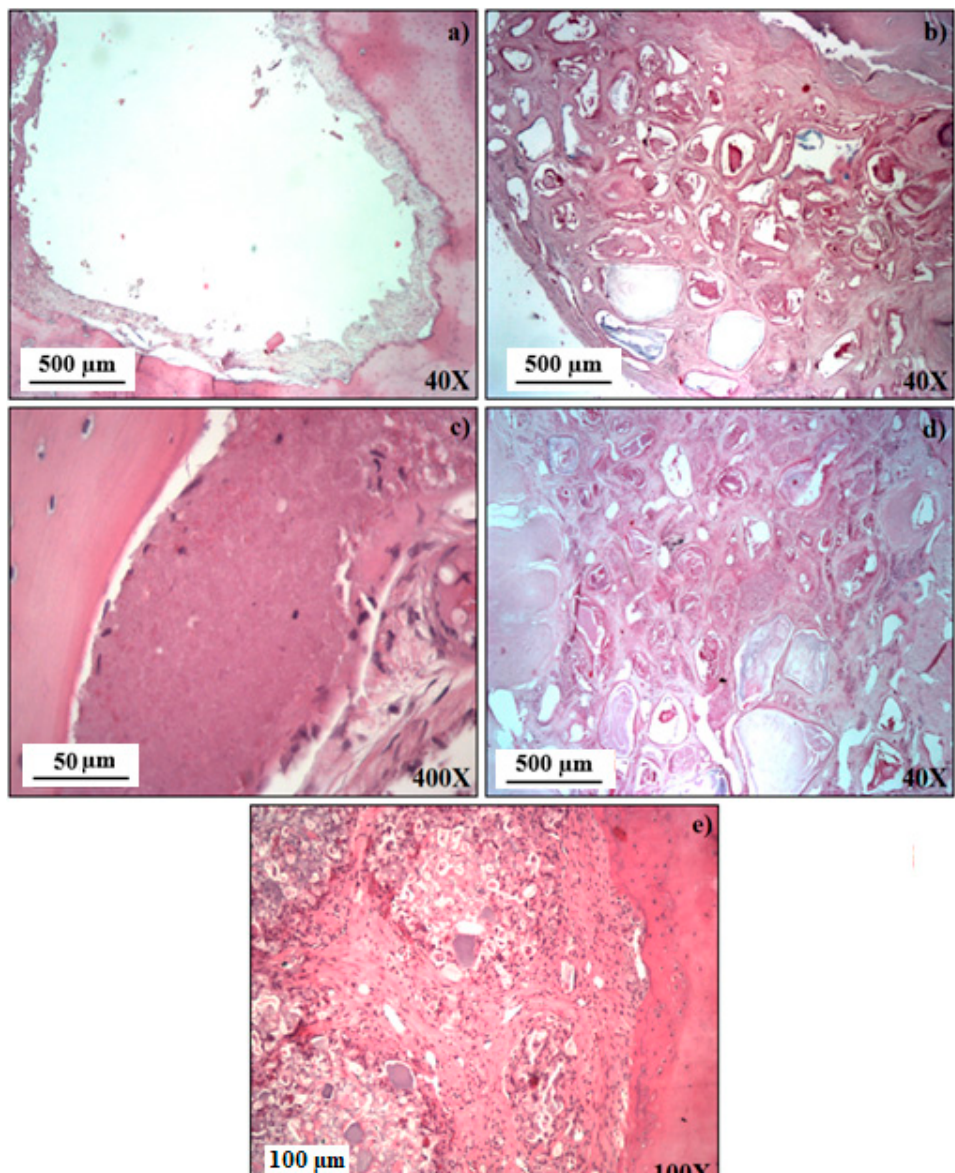
Figure 6. Histological images (H&E staining) of bone defects 9 weeks after treatment: ( a ) empty defect; and defects filled with: ( b ) BG; ( c ) 3TCP0/7BG; ( d ) 3TCP1/7BG; ( e ) 3TCP2/7BG. The Figure shows representative images of at least 5 independent experiments.